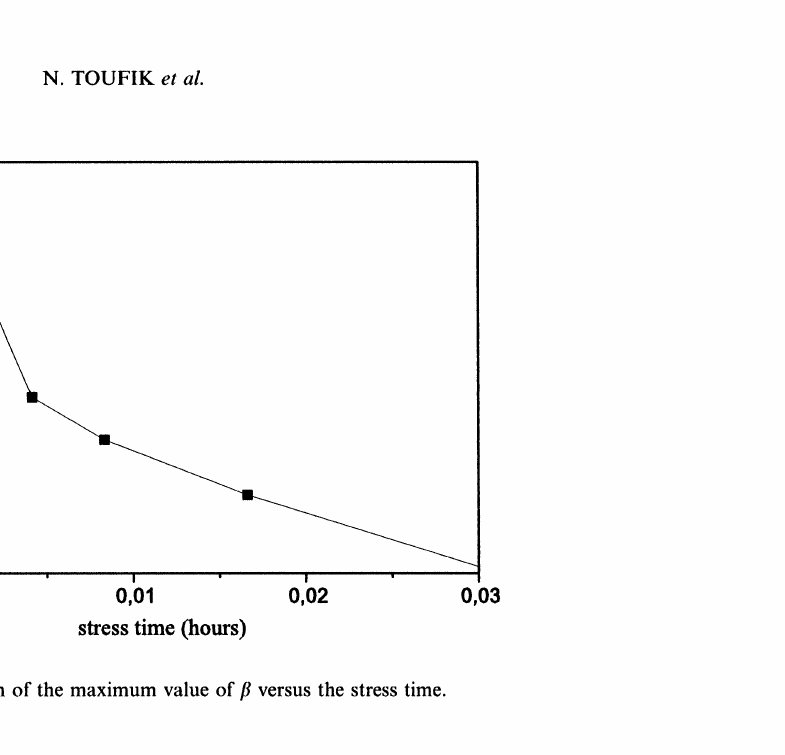
FIGURE 5 Variation of the maximum value of/3 versus the stress